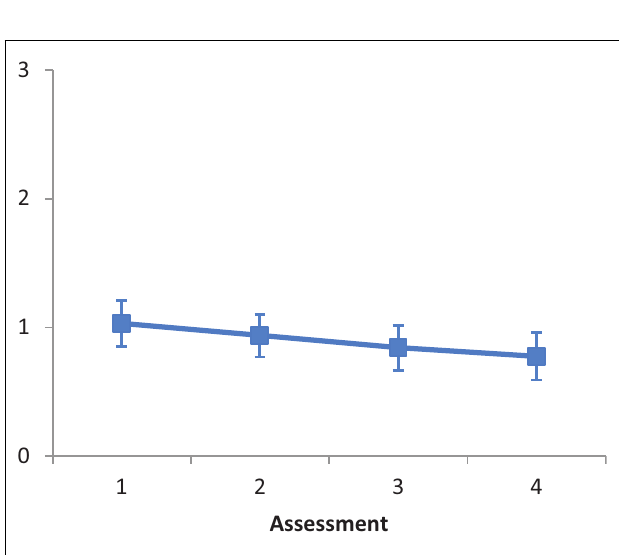
FIGURE 5 | LN patients’ performance on the Card dealing subtest as a function of assessment . Error bars represent 1 SEM.